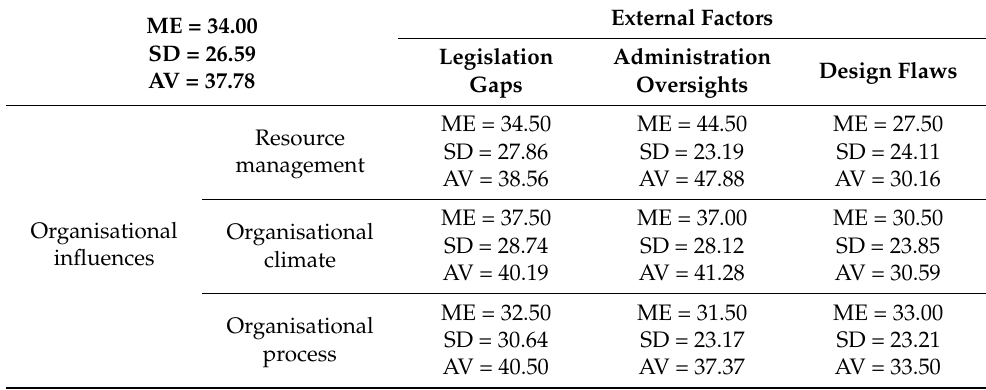
Table A1. Median (ME), standard deviation (SD), and average (AV) for responses on Stage 1 (how External factors affect the occurrence of Organisational influences).